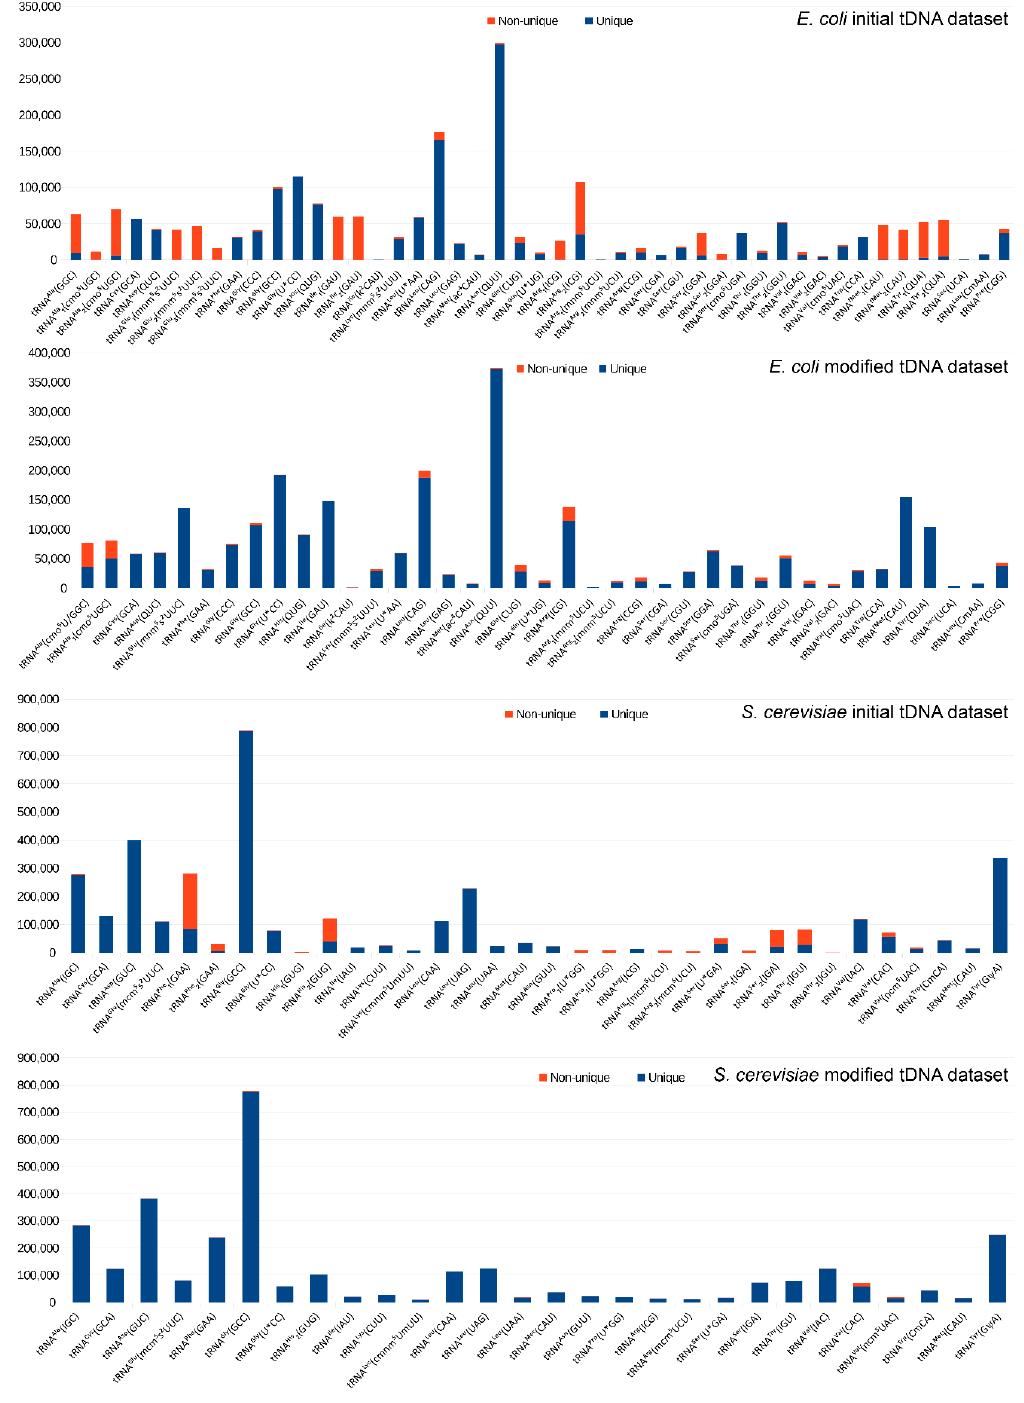
Figure 4. Proportion of non-uniquely mapped reads with initial and collapsed (optimized) transfer DNA (tDNA) datasets for each tRNA species. For both datasets, the number of uniquely and non-uniquely mapped reads was calculated for each tRNA species and plotted as stacked bars. The positions of the 5 (cid:48) - and 3 (cid:48) -ends were cumulated together to obtain the global end-coverage profile, and these data were used to calculate RiboMethSeq scores (ScoreMean (derived from ScoreMax) and ScoresA, B and MethScore(C)) as described previously [63,65]. Since the length of tRNA